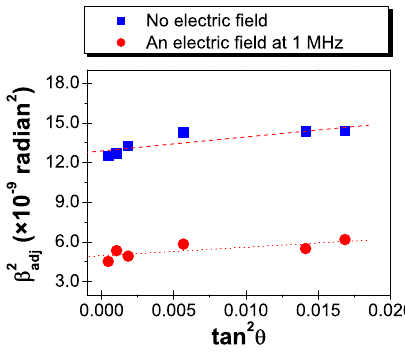
Figure 5. Relationship between β 2 and tan 2 θ for tetragonal HEW lysozyme crystals prepared with adj and without an external electric field at 1 MHz. The FWHMs were analyzed using a beam spot diameter of 896.55 µ m (139 pixels).